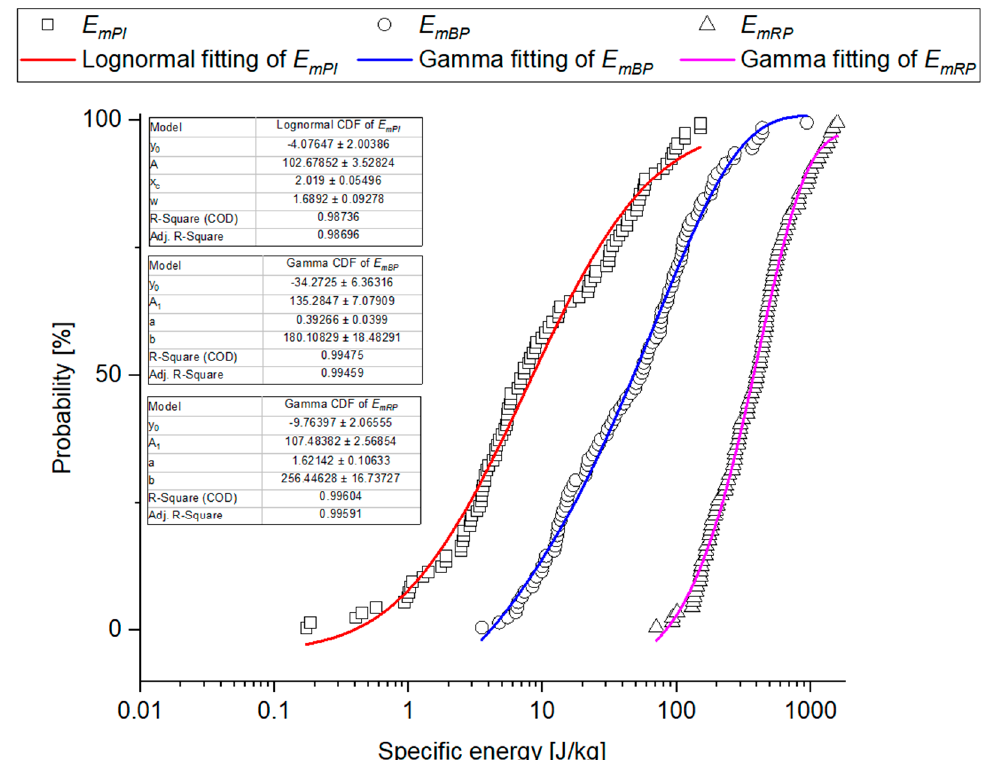
Figure 12. Probability plot distributions fitted to experimental values of specific energy.